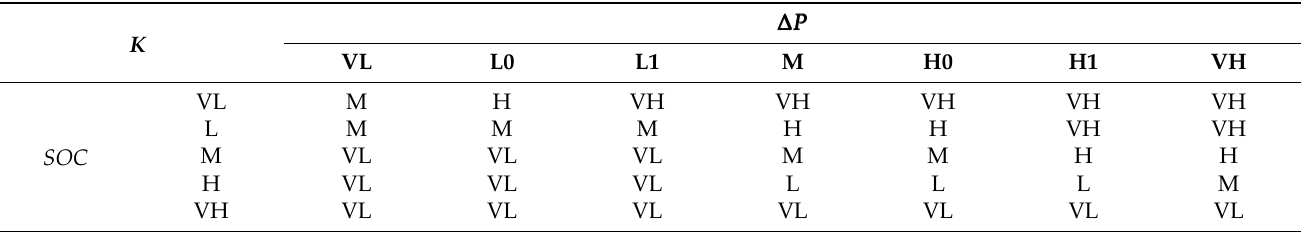
Table 2. Fuzzy rules.